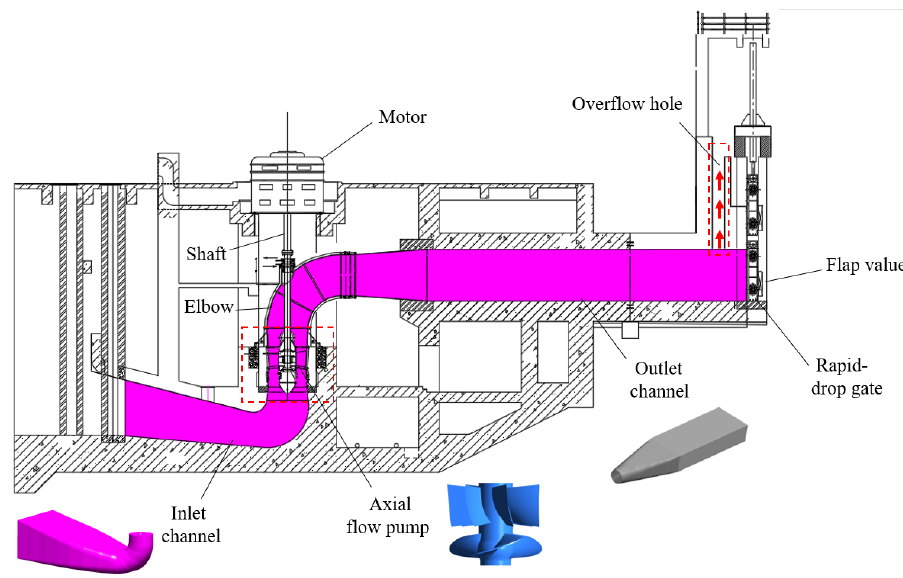
Table 1. Characteristic parameters of a large axial flow pump station system.